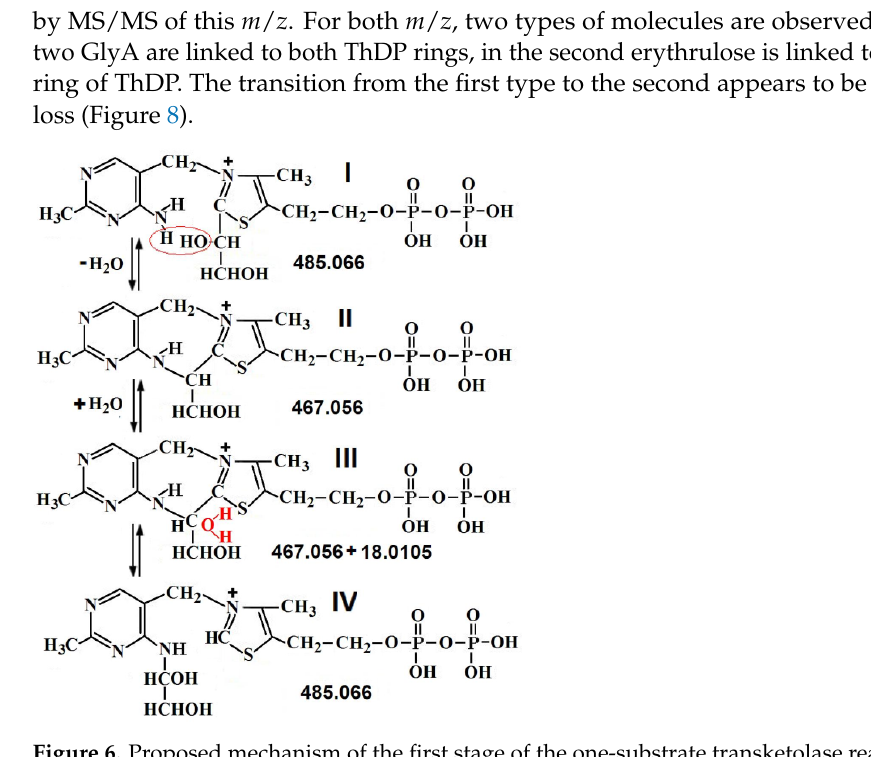
Figure 8. Proposed mechanism of the second stage of the one-substrate transketolase reaction.